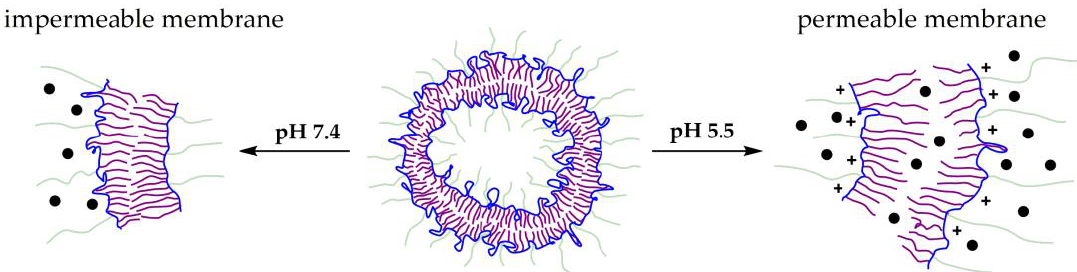
Figure 10. Schematic overview of pH-responsive polymersomes ’ membrane behavior in neutral and acidic environments.